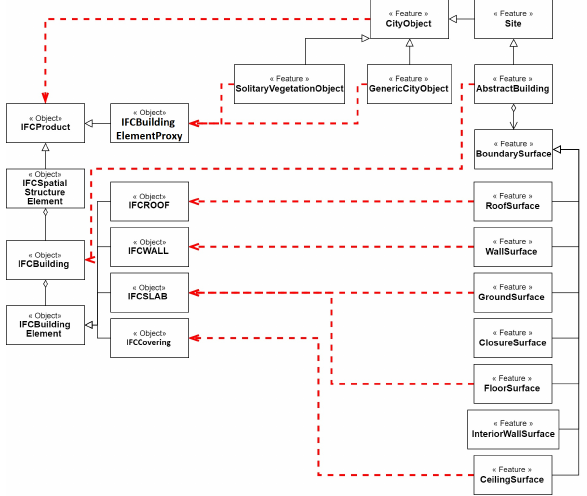
Figure 6. Semantic mapping application